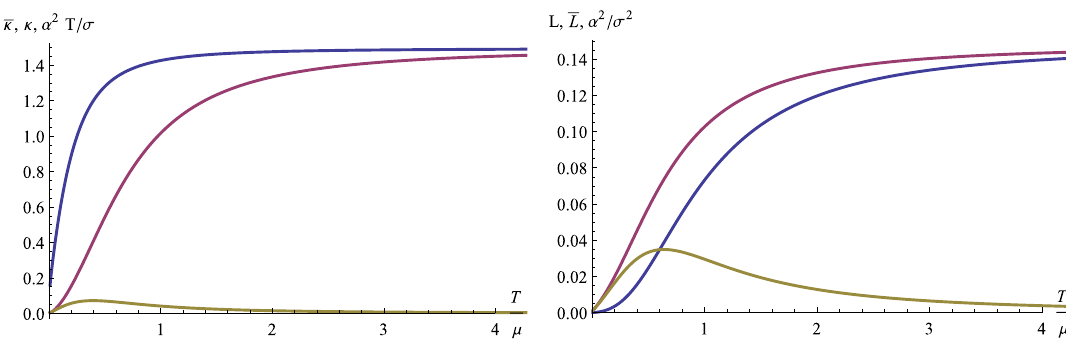
Figure 6 . Left: thermal conductivities (cid:22) (cid:20) (Blue) and (cid:20) (Purple) and the di(cid:11)erence between the two of them (cid:11) 2 T=(cid:27) (Yellow) as a function of the reduced temperature. Right: Wiedemann-Franz ratios L (Blue) and (cid:22) L (Purple) and the di(cid:11)erence between these two (cid:11) 2 =(cid:27) 2 (Yellow) as a function of the